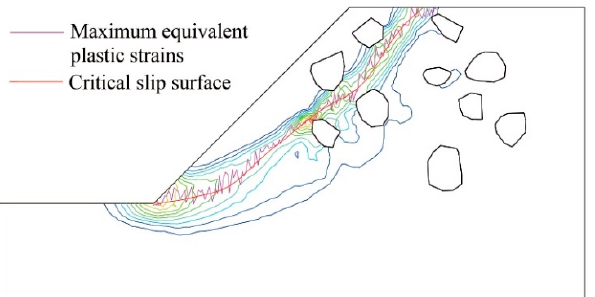
Figure 18. The contour of equivalent plastic strain, distribution of the maximum equivalent plastic strains, and the CSS for Example 3.